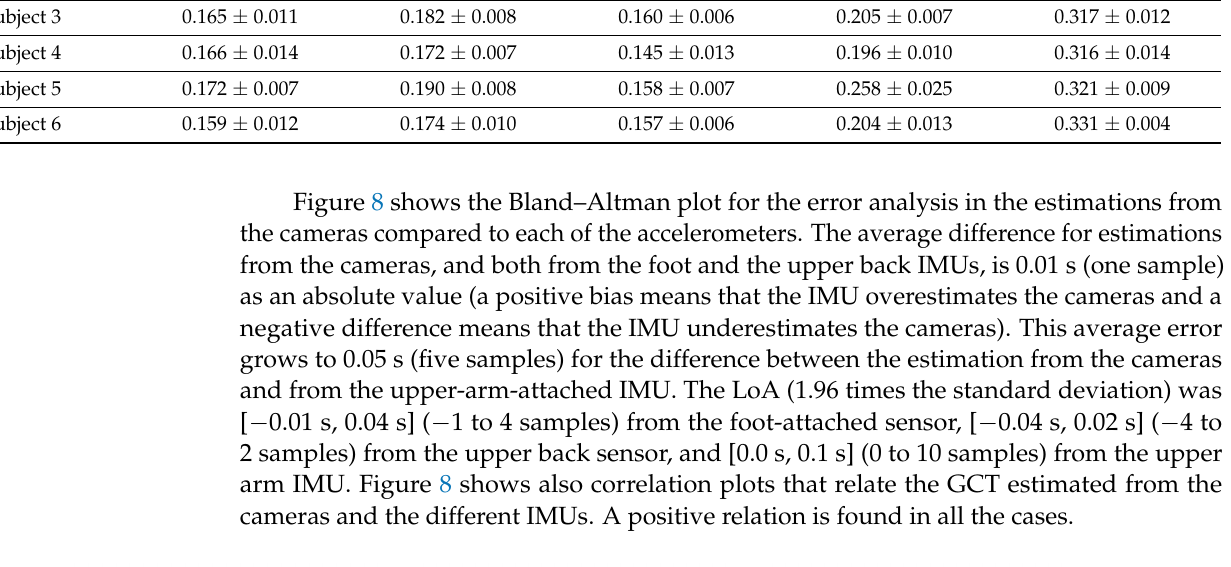
Table 3. Ground contact time in seconds (mean ± std) for the different subjects using the different sensors. The right-hand column shows aggregated results for the step time identified using the cameras.